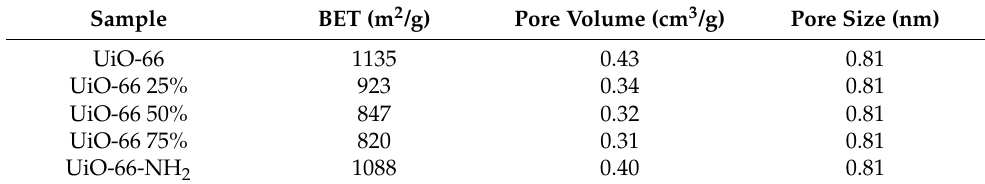
Table 2. Structure parameters of UiO-66 X%.